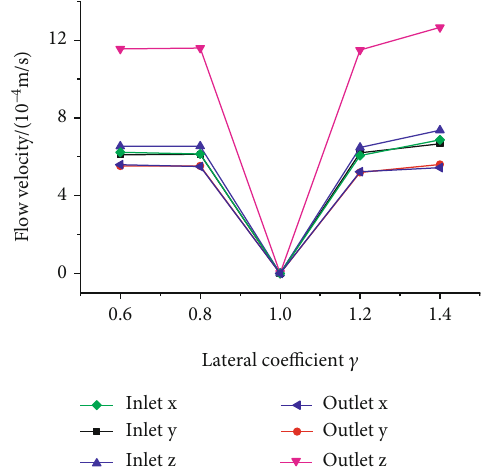
Figure 11: Relation curve of fl ow velocity with di ff erential lateral coe ffi cient γ .